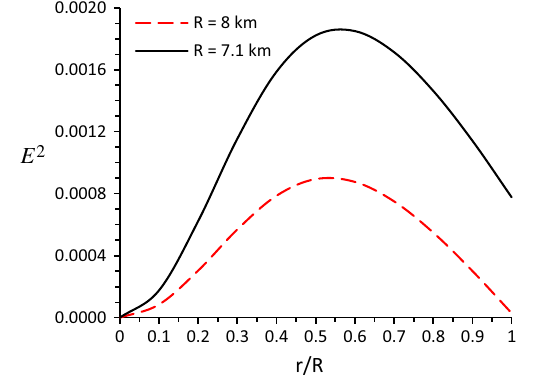
Fig. 9 Behavior of electric field ( E 2 ) versus radial coordinates r / R